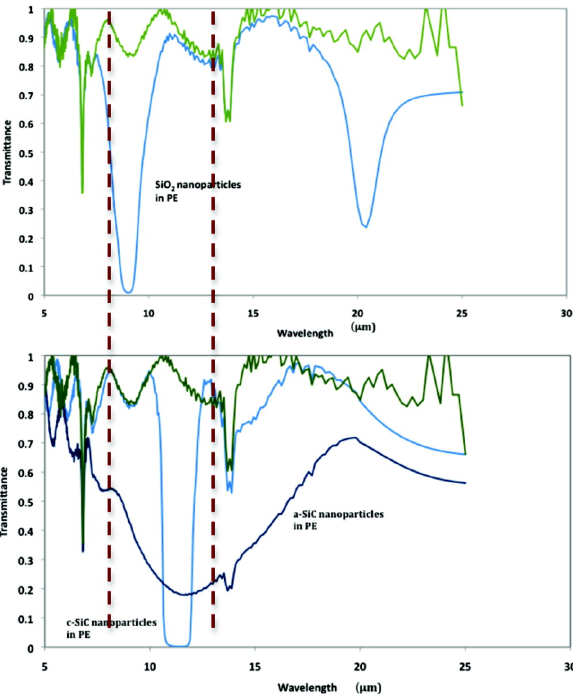
Fig. 6. Transmittance spectra (light blue) of crystalline silica and silicon carbide nanoparticles embedded in polyethyelene. These particles resonate at sections of sky window wavelengths where SiO 2 and SiC have negative real permittivity from their phonon re- sponses. Amorphous SiC nanoparticles (dark blue) are only weakly selective as they are much more lossy than their crystalline counter- parts. The green plot is for the undoped PE [8].